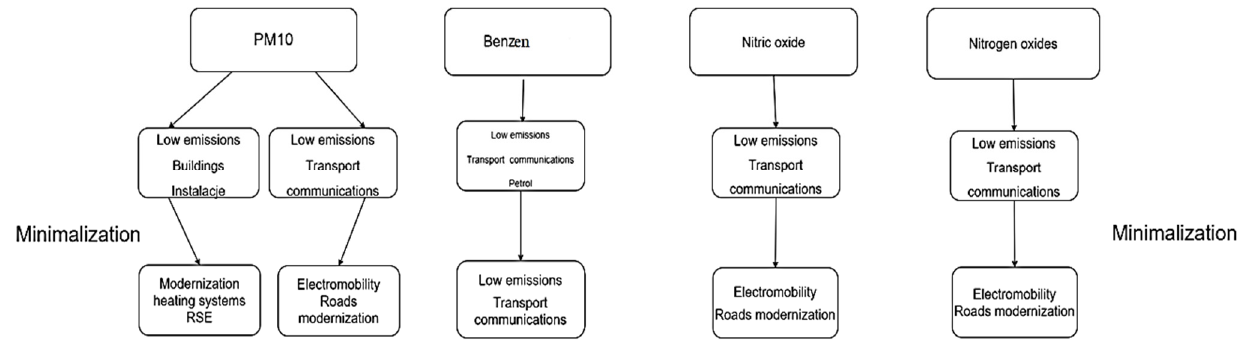
Figure 25. The concept of reducing the level of air pollution.